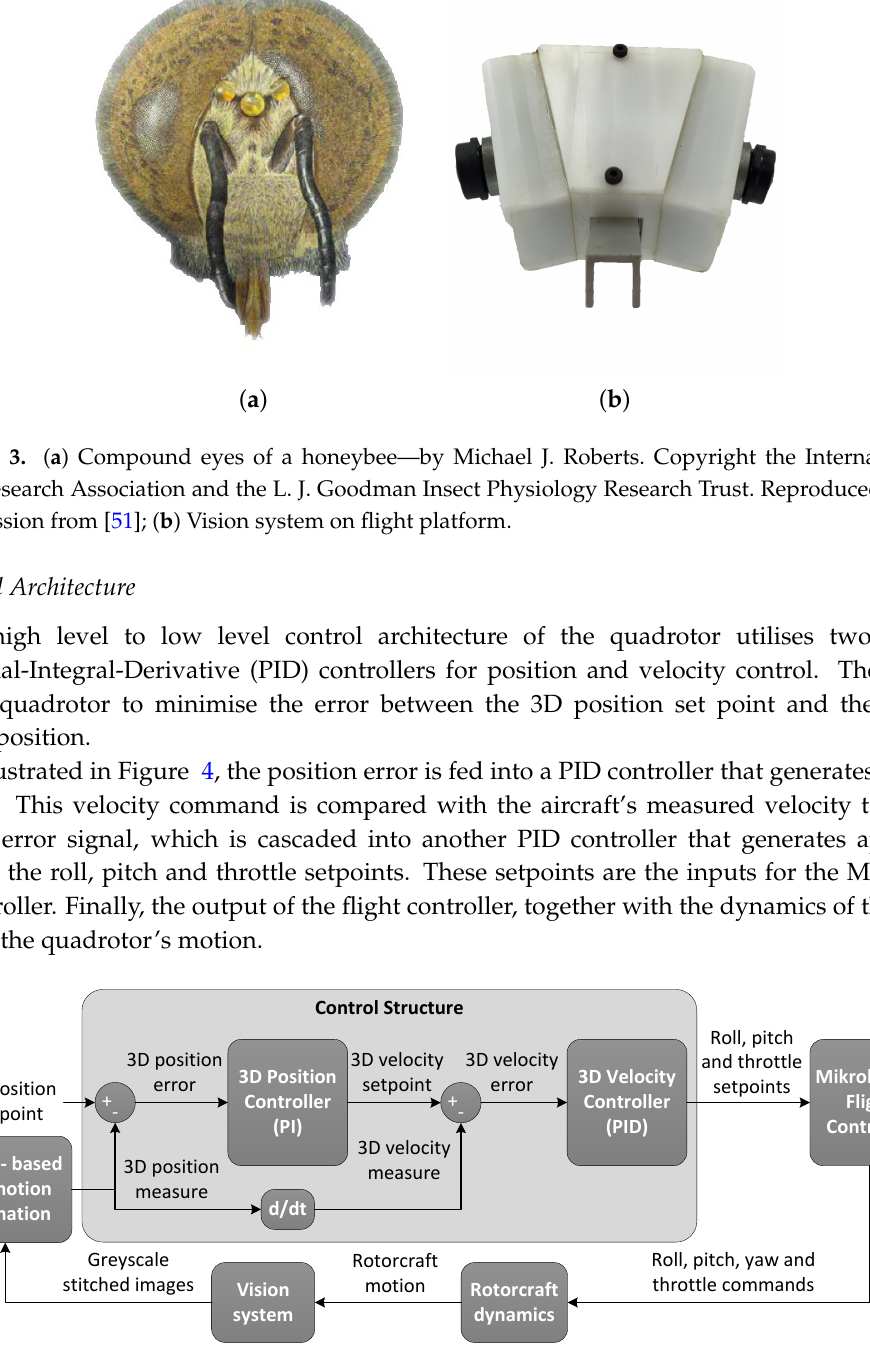
Figure 4. Control architecture used by vision-based algorithms onboard the flight